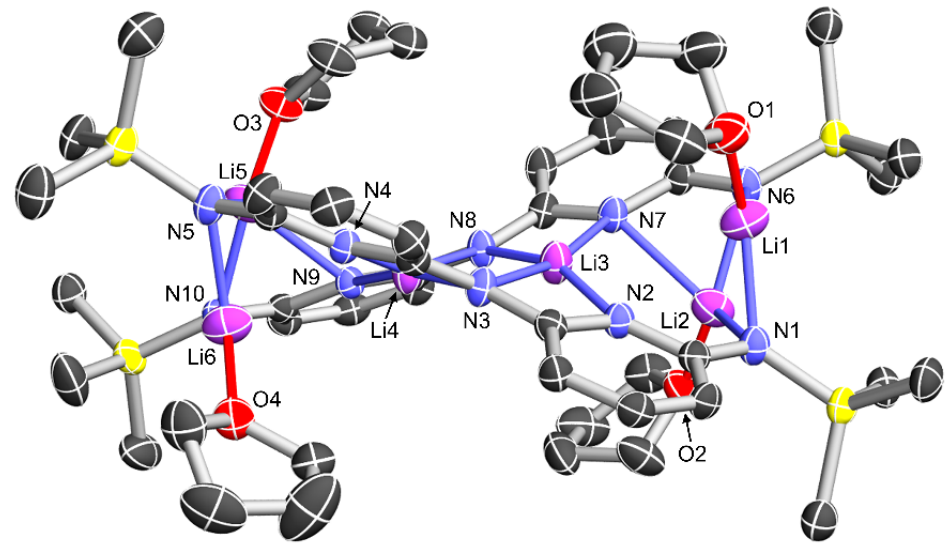
Figure 4. Molecular structure of mol1 in 2 , viewed approximately along the line joining N3 and N8. Same color code as in Figure 3. Thermal ellipsoids are at 60% probability level and hydrogen atoms are omitted for clarity.